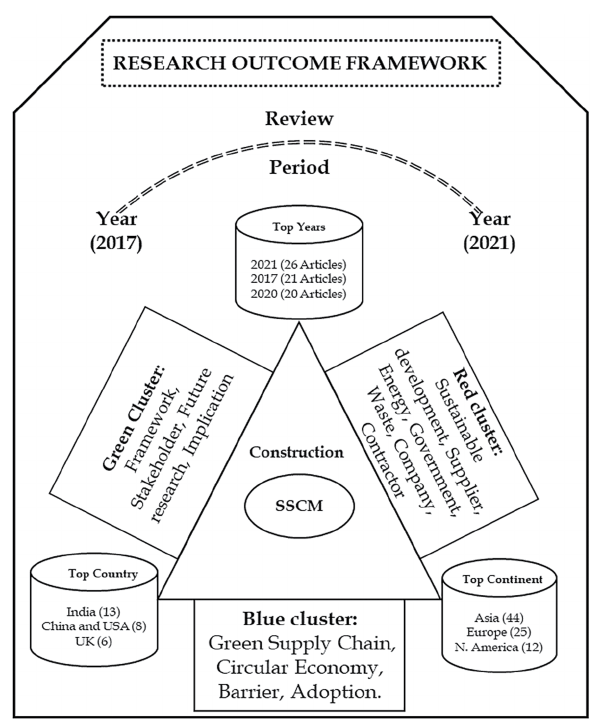
Figure 6. Research outcome